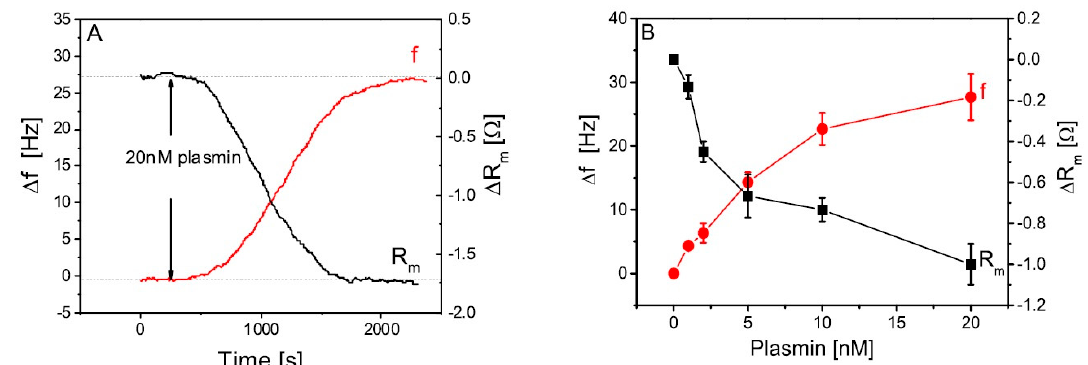
Figure 7. ( A ) Changes in the resonance frequency ( Δ f) and motional resistance ( Δ R m ) of the quartz crystal microbalance (QCM) transducer modified by a 1-mM peptide substrate and mercaptohexanol after the addition of 20-nM plasmin. ( B ) Plots of relative changes of the Δ f and Δ R m , a function of plasmin concentration ( Δ f = f − f 0 and Δ R m = R m − R 0 ); here, f 0 and R 0 are the frequency and resistance measured before the addition of plasmin, respectively. The results represent the mean ± S.D. obtained from 3 independent measurements performed for each concentration of plasmin. Reproduced with permission of Elsevier from Poturnayova et al. [63].